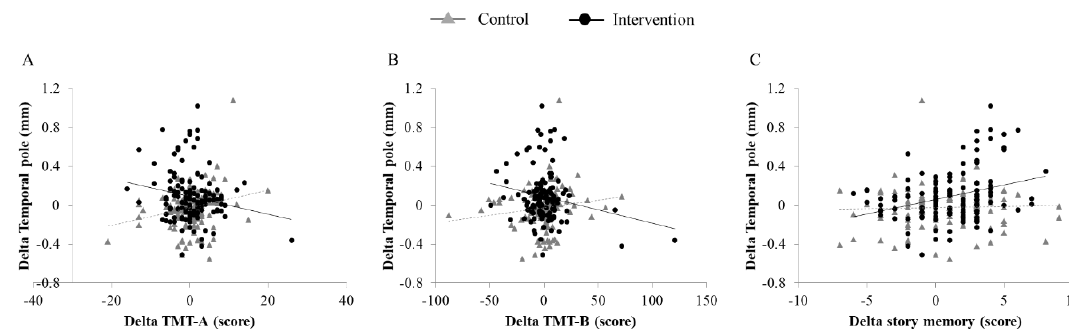
a Pearson’s correlation analysis. b Linear regression analysis controlling for age, gender, years of education, geriatric depression scale, and estimated total intracranial volume. TMT: trail making test; SDST: symbol-digit substitution test; ∆ , delta score.